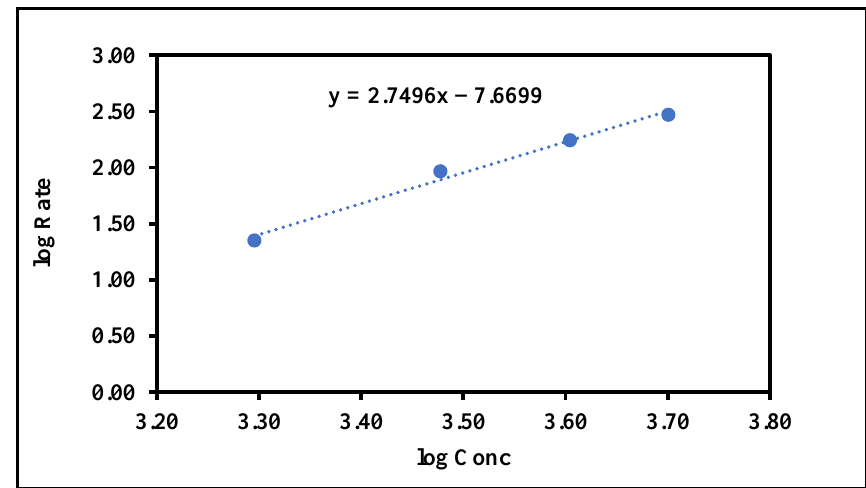
Figure 2. Effect of concentration on the rate of gypsum crystallization (2000 – 5000 mg/L CaSO 4 (as Ca), 5 g/L gypsum seed, 0 g/L Fe 3+ , 0 mg/L Inh, 25 °C, stirring rate: 200 rpm; Stirring time (min): 180/180).-